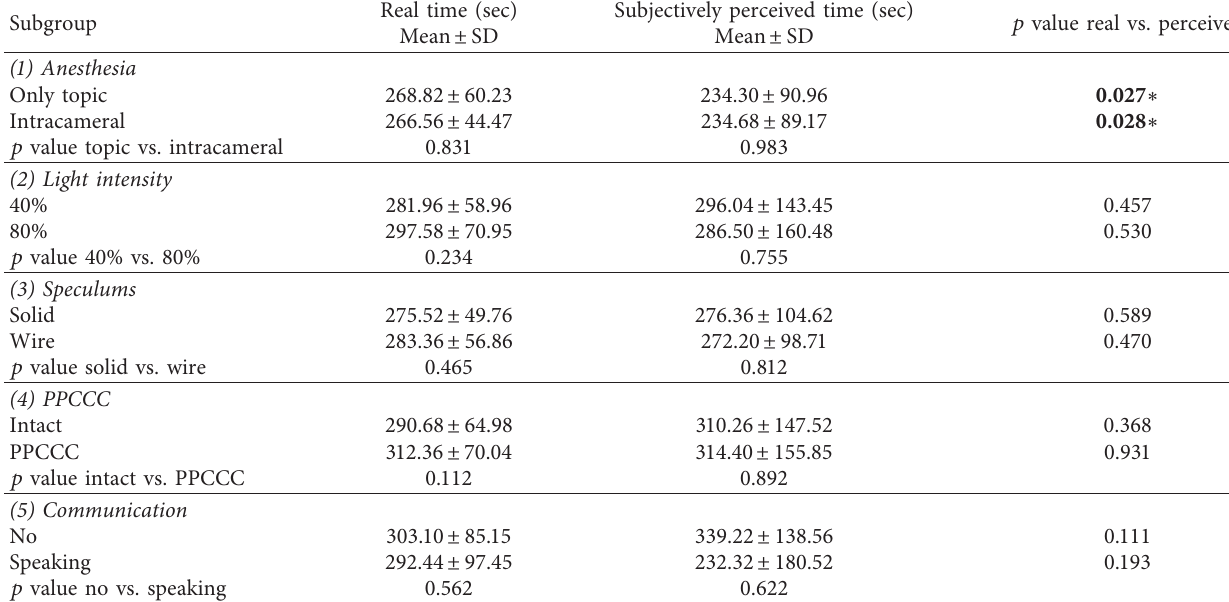
Table 5: Comparison of perception of time between eyes with and without changing parameters of surgery in 5 subgroups: mean ± SD; p values of paired t -test between real and subjectively perceived